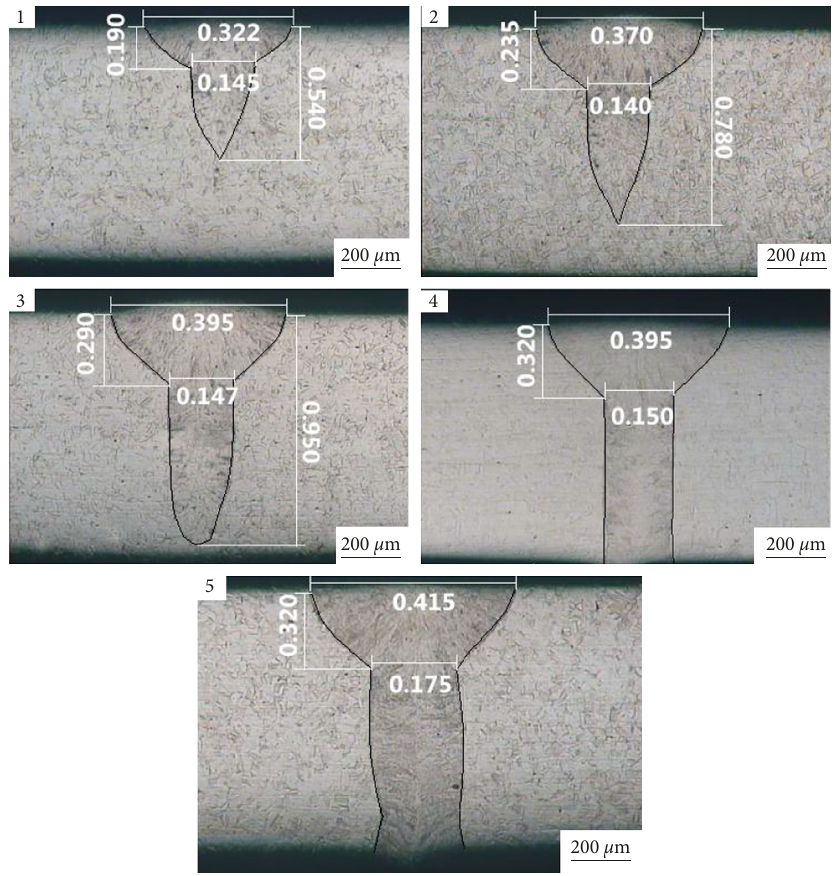
Figure 5: Weld profile for different laser powers. (1) 200W; (2) 250W; (3) 300W; (4) 350W; (5)